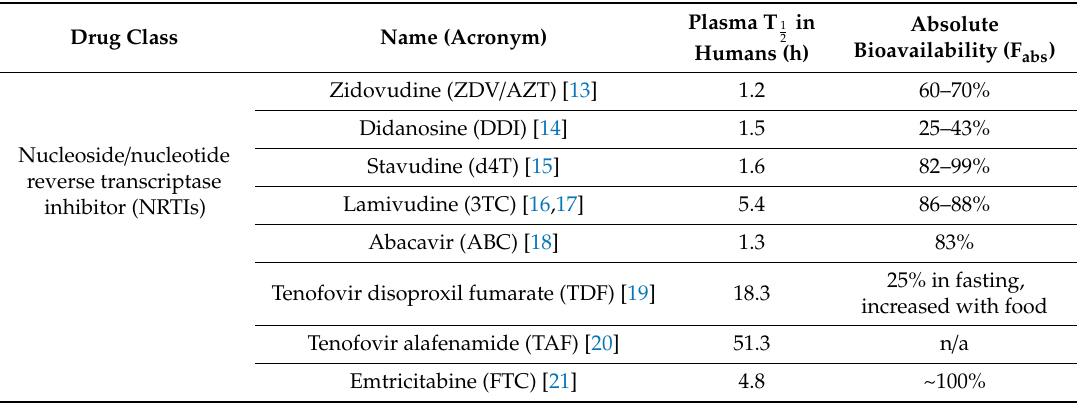
Table 1. FDA-approved pharmaceuticals for HIV treatment of HIV